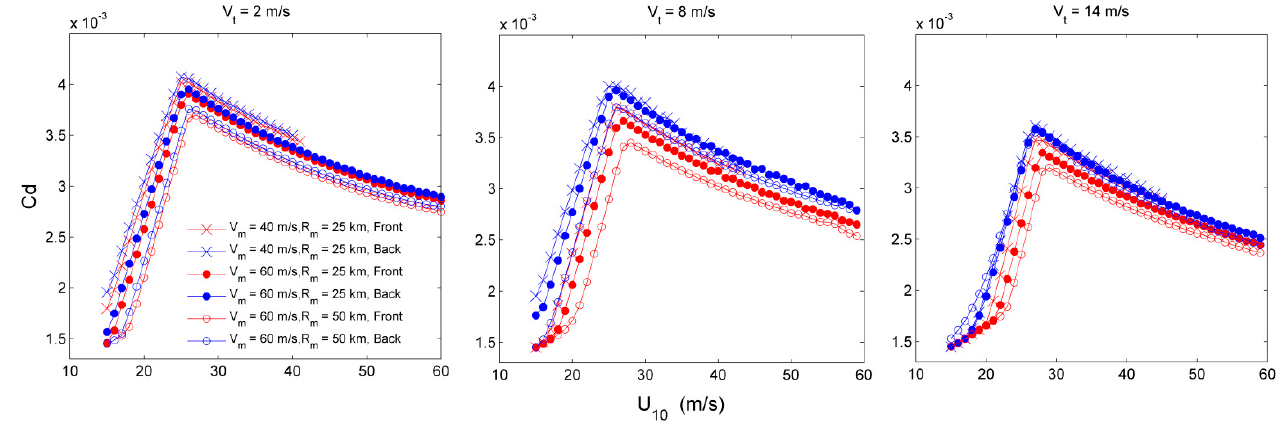
Figure 6. The variation in the calculated drag coefficient with the wind speed for different TC pa- rameters.